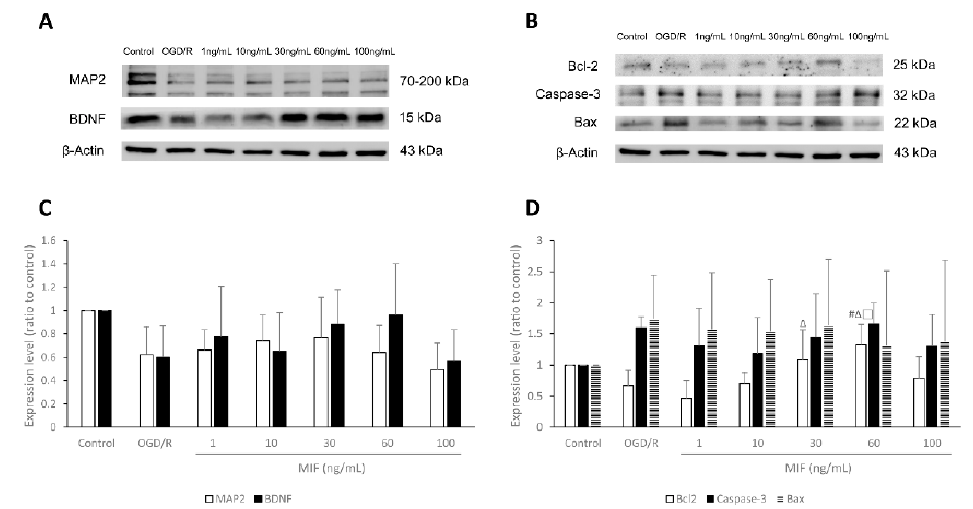
Figure 3. Western blot analysis of microtubule associated protein 2 (MAP2), brain-derived neurotrophic factor (BDNF), B-cell lymphoma 2 (Bcl-2), Caspase-3, and Bcl-2-associated X (Bax) expression under the control, OGD/R, and OGD/R conditions treated with different concentrations of MIF. ( A , B ) Representative bands of each group in the Western blot; ( C , D ) the expression of Bcl-2 was significantly higher in the 60 ng/mL MIF group than in the OGD/R group. Mean ± SD values are presented. # p < 0.05 vs. OGD/R group; ∆ p < 0.05 vs. 1 ng/mL MIF group; □ p < 0.05 vs. 10 ng/mL MIF group. Differences between the groups were analyzed using one-way ANOVA followed by Tukey’s post hoc test (number of independent cell culture experiments ( n ): all, n = 5).